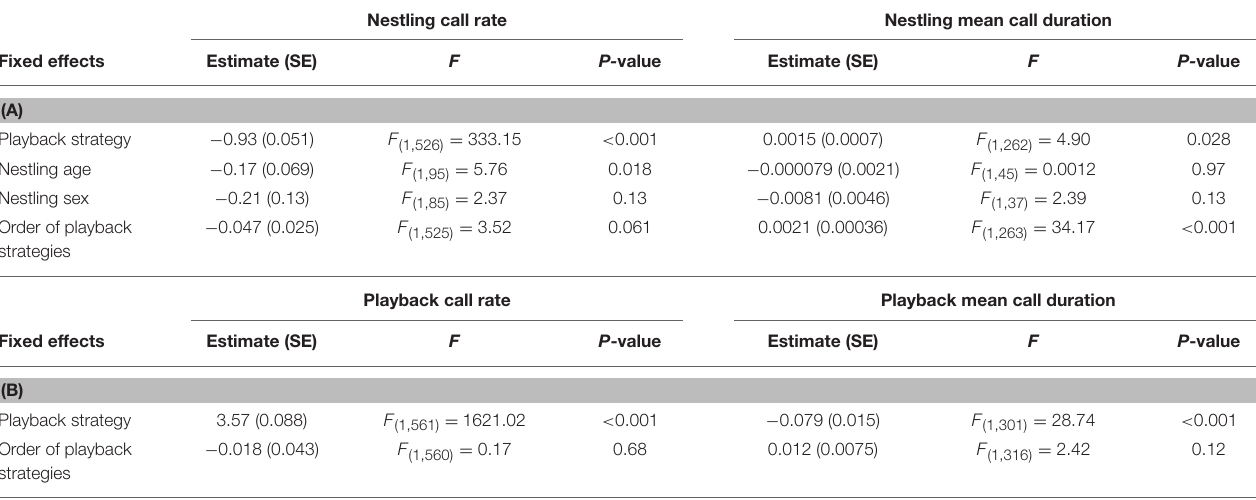
TABLE 1 | Effect of the playback strategies on the vocal behavior of nestling barn owls (A) and of the playback (B)